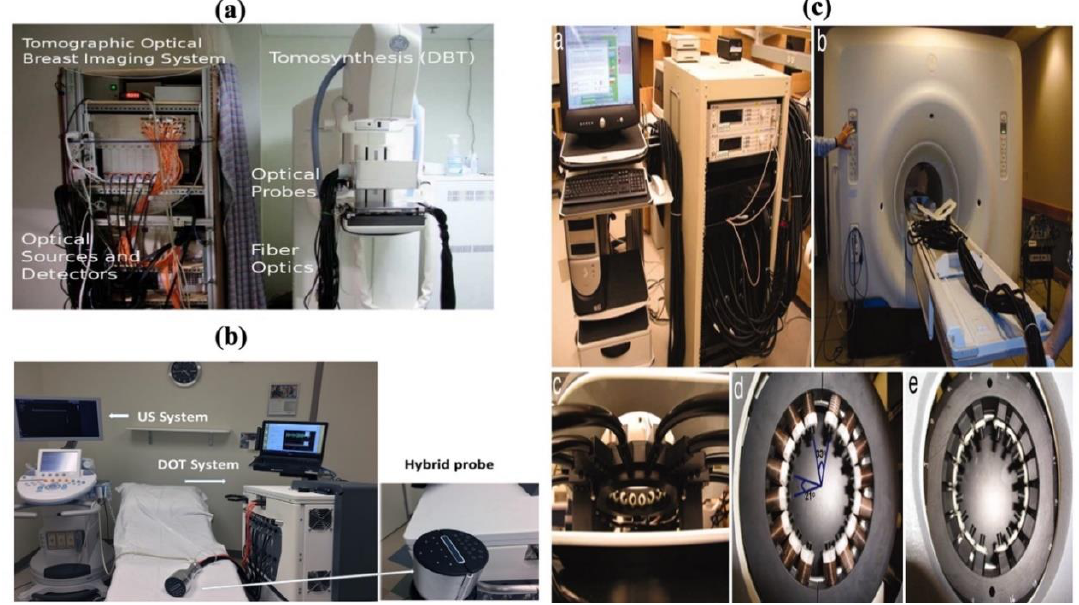
Figure 14. Co-registration of FD-NIRS optical tomography with ( a ) mammography (Reproduced from reference [85]); ( b ) ultrasound (Reproduced from reference [84]); and ( c ) with MRI for breast imaging [82]; Copyright (2006) National Academy of Sciences, U.S.A.